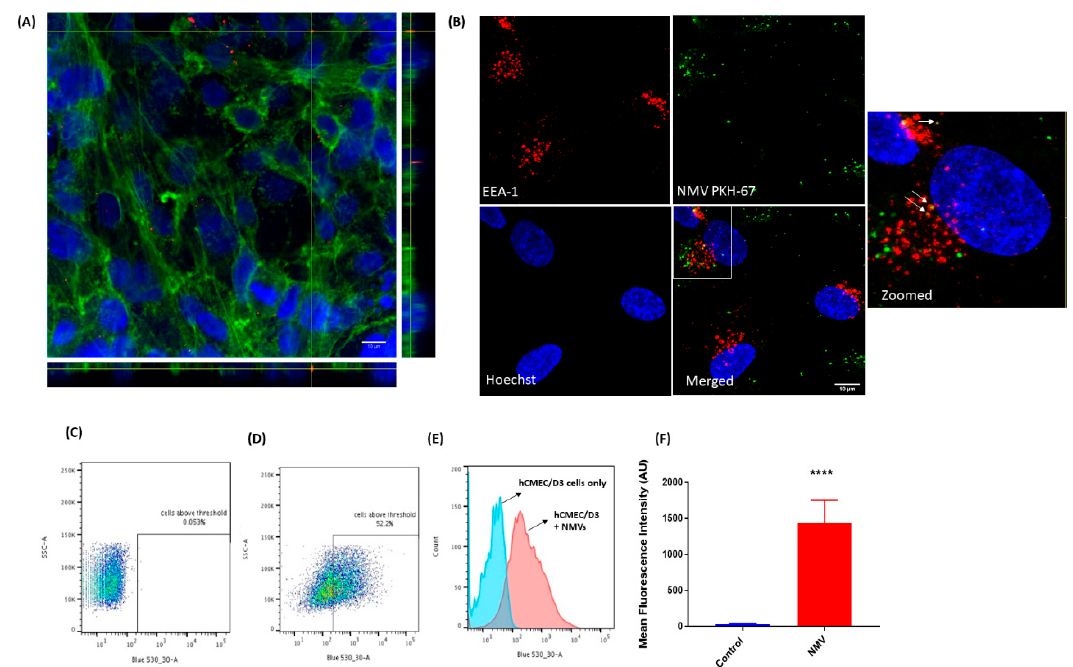
Figure 2. Internalization of NMV by hCMEC/D3. ( A ) NMV interaction was visualized using confocal microscopy. PKH-26- NMV (red) were incubated with hCMEC/D3 for 2 h, fixed and stained (FITC-phalloidin (green) and Topro-3-iodide (blue). Orthogonal views demonstrated the presence of NMV inside the cells. Images were obtained on Zeiss LSM 510 confocal and 63×/1.4 oil immersion lens. ( B ) Confocal analysis of hCMEC/D3 stained for EEA-1 antigen (red), PKH-67 NMV (green) and counter-stained for nuclei (blue). Zeiss LSM 880 with Airyscan with a 63× oil immersion lens was used to obtain the images. Zoomed in image (50%). ( C ) PKH-67- NMV were incubated with hCMEC/D3 for 2 h and cells analyzed for fluorescence by flow cytometry. Trypan blue (1 mg/mL) was added to the